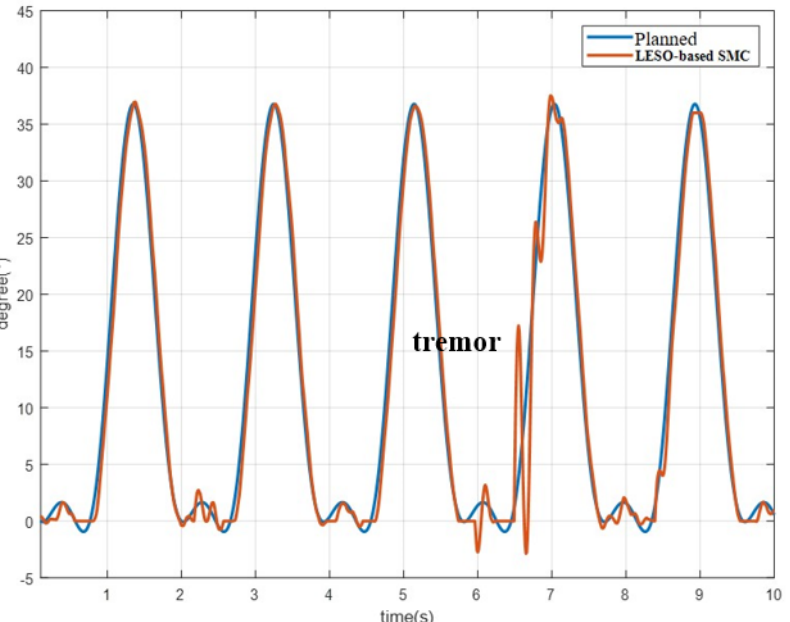
Figure 14. Trajectories of hip joint by LESO-based SMC with spasm and tremor occurring at walking speed = 0.225 m/s.